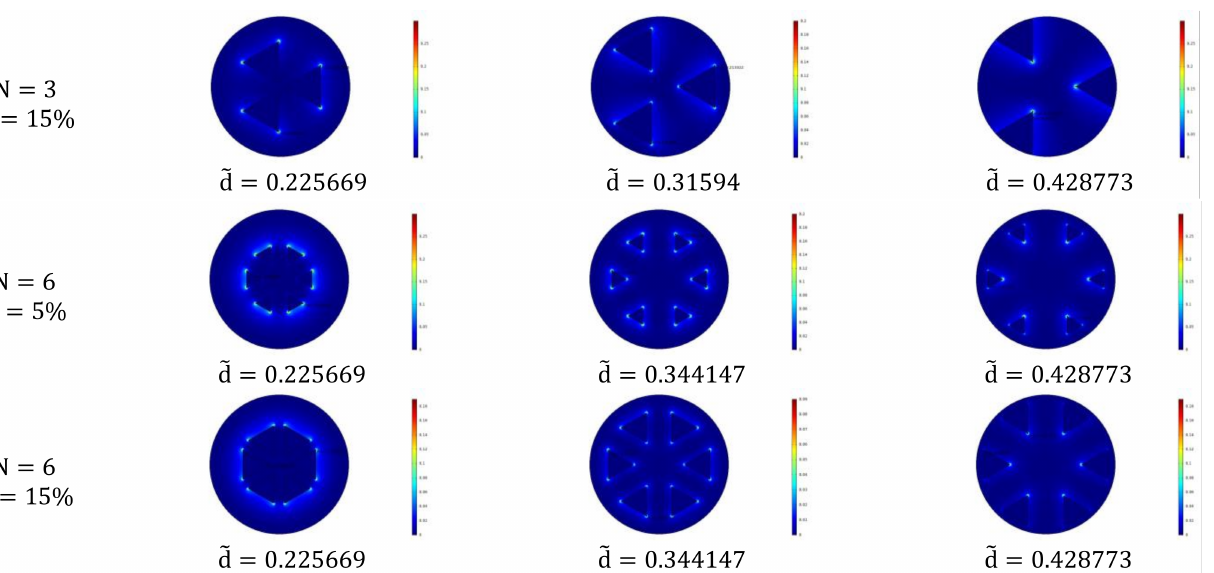
Figure 16. The entransy dissipation cloud chart of model